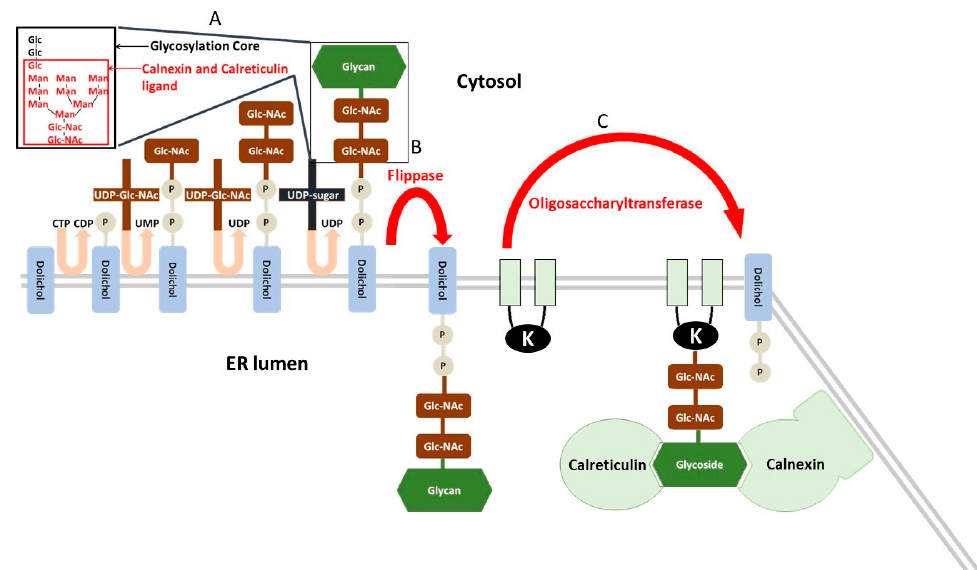
Figure 2. N -glycosylation of protein in the endoplasmic reticulum (ER). ( A ) Synthesis of glycosylation core (Glc3Man9NAcGlc2) on dolichol attached to the ER membrane and oriented to the cytosol; ( B ) Relocation of the newly synthetized glycosylation core from the cytosolic to the luminal side of the ER by distributing flippase [58]; ( C ) Transfer of glycosylation core from dolichol phosphate to protein by oligosaccharyltransferase (EC 2.4.1.119) [62] and specific linkage of new glycoprotein with Ca 2+ -dependent lectins/chaperones of ER calnexin and calreticulin [63,64] due to its affinity for the oligosaccharide moiety labelled by a red square in A.